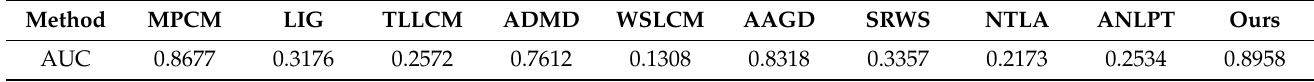
Table 9. AUC of di ff erent methods when the SNR is 0.5 dB. Table 9. AUC of different methods when the SNR is 0.5